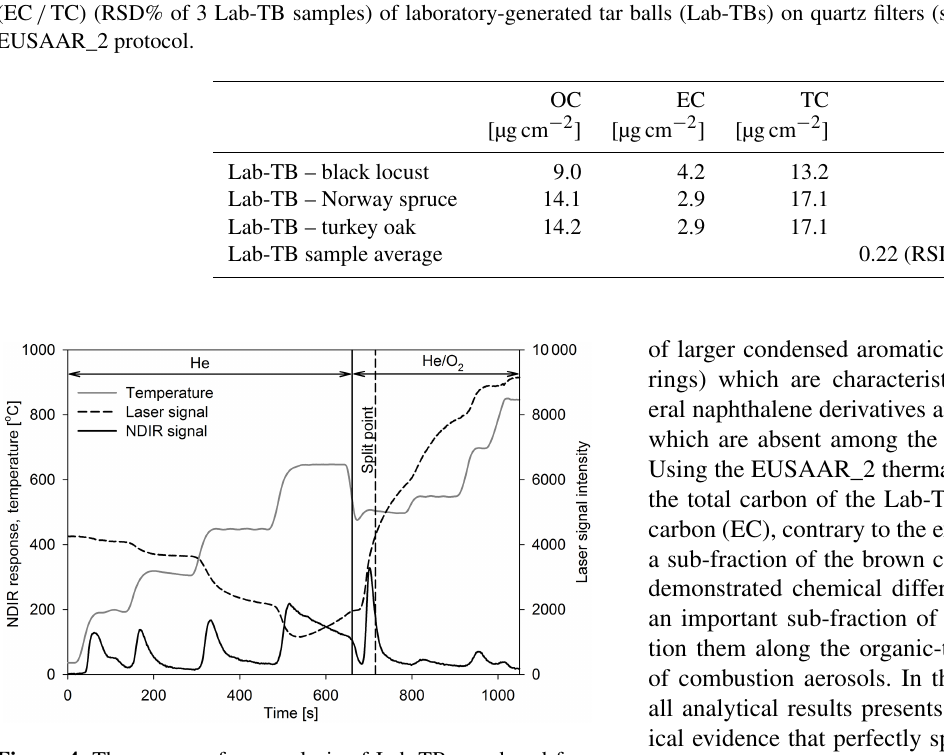
Figure 4. Thermogram from analysis of Lab-TBs produced from Norway spruce, measured by thermal–optical analysis (TOA) ob- tained by the EUSAAR_2